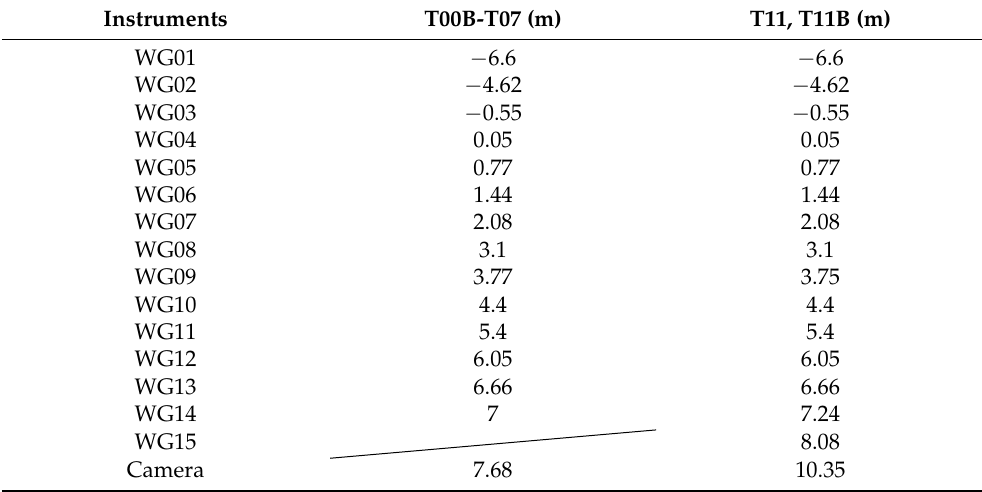
Table 1. Horizontal positions of instruments (unit: m). x = 0 is defined at the toe of the sloping bed. Instruments